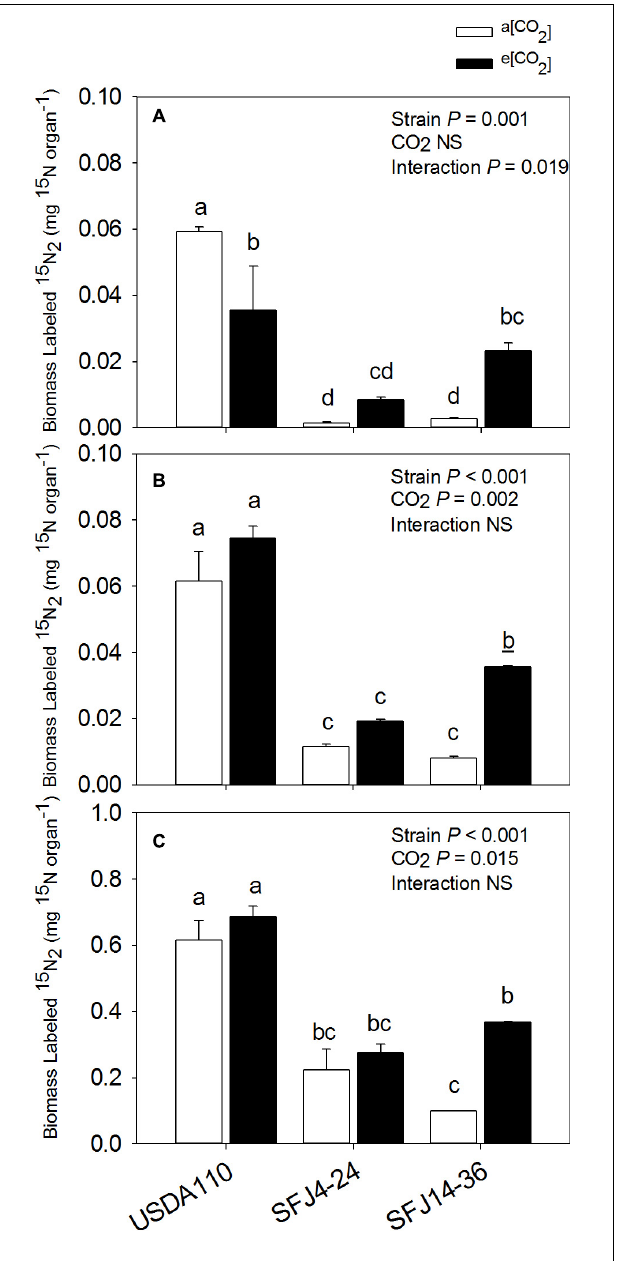
FIGURE 3 | Effect of [CO 2 ] on biomass labeled 15 N in three organs of soybean plants inoculated with three different B. japonicum strains. Biomass labeled 15 N (mg 15 N organ - 1 ) in (A) nodules, (B) roots, and (C) leaves of soybean grown at a[CO 2 ] (400 ppm) and e[CO 2 ] (700 ppm) and inoculated with three Bradyrhizobium japonicum strains (USDA110, SFJ4-24, and SFJ14-36). Bars correspond to the mean ± SE of n = 3. Results of statistics are shown (two-way ANOVA, P < 0.05). Different letters indicate significant differences (Tukey post hoc test P < 0.05).